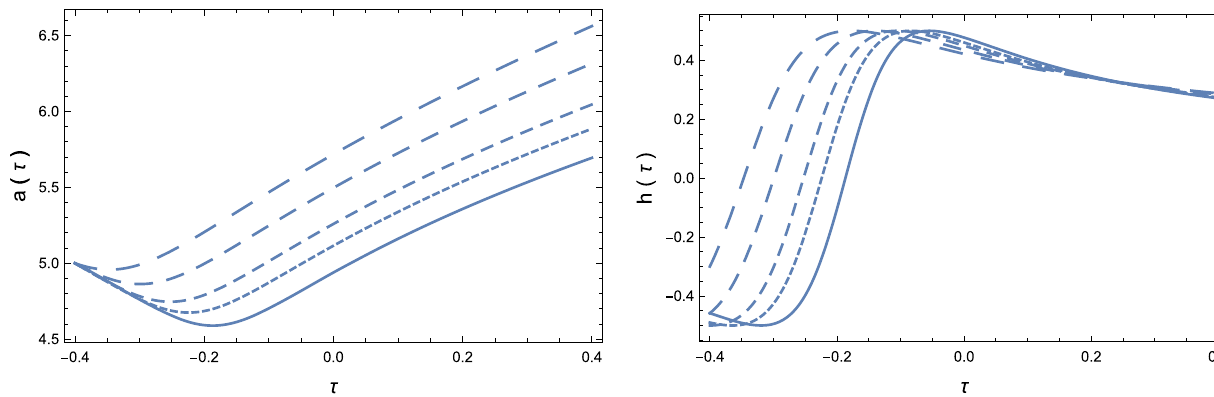
Fig. 1 Time evolution of the scale factor a (left figure) and of the dimensionless Hubble function h (right figure) in a loop quantum cos- mological Universe filled with a deformed photon gas with the disper- sion relation E = kc ( 1 + λ E ) with λ k B T >> 1, for different values of the parameter A 1 : A 1 = 3 × 10 − 3 (solid curve), A 1 = 4 × 10 − 3